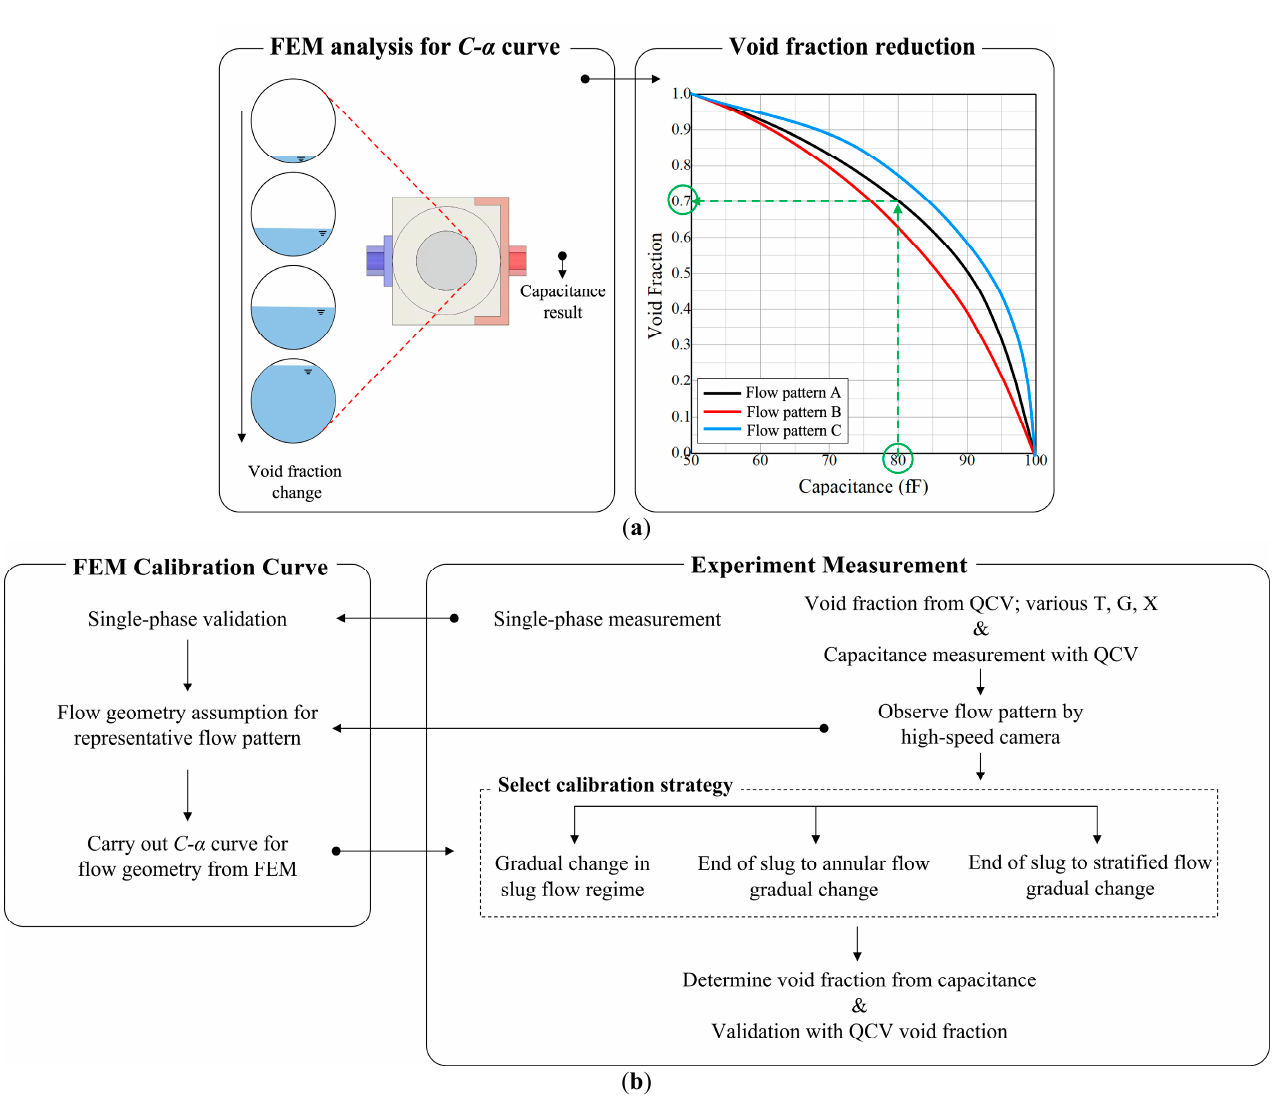
Table 3. Single-phase validation results.